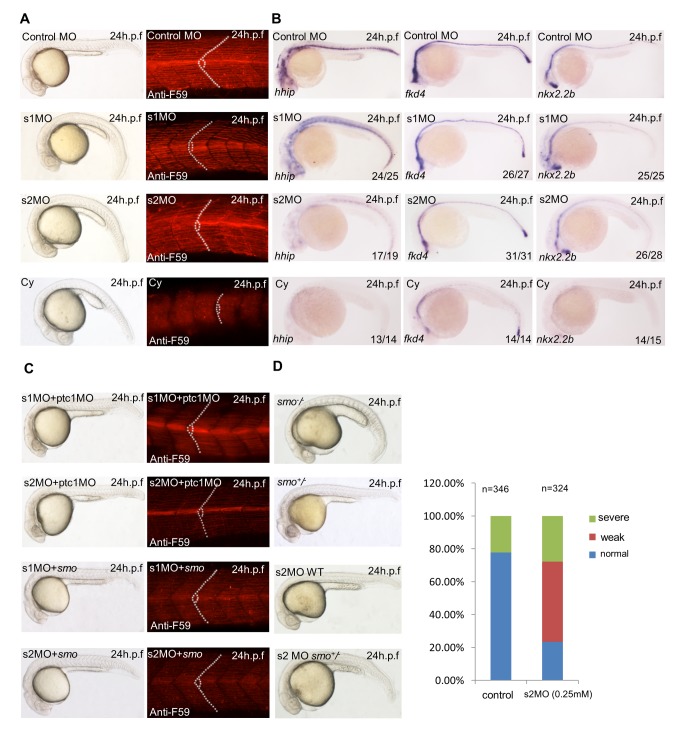
Smurfs are involved in the regulation of hedgehog signaling pathway in zebrafish.(A) smurf1 and smurf2 morphants mimic loss-of-Hh phenotype. Compared with control MO-injected embryos (top panels), embryos injected with 4 ng of smurf1-atg MO (s1MO) or of smurf2-atg MO (s2MO) displayed weakly curled tails, U-shaped somite, and disrupted somitic muscles of the mid-trunk region, as revealed by anti-F59 immunostaining (middle panels), which are similar to but weaker than cyclopamine-treated embryos (bottom panels). (B) Downregulation of three Hh-responsive target genes, hhip, fkd4, and nkx2.2b in smurf MOs. (C) Co-injection of smurf MOs (4 ng) with 4 ng ptc1MO (top two panels) or 100 pg smo mRNA (bottom two panels) can rescue the Hh-like phenotype of smurf1 or smurf2 MOs. (D) Injection of a low dose of s2MO (2 ng) into smo
+/− embryos resulted in an Hh-like phenotype (bottom panel), but did not show any phenotype in the WT (smo
+/+) embryos (middle panel). Statistical data are shown in the right panel. smo
−/− embryos showed a typical Hh phenotype (top panel), while smo
+/− embryos were normal (middle panel).